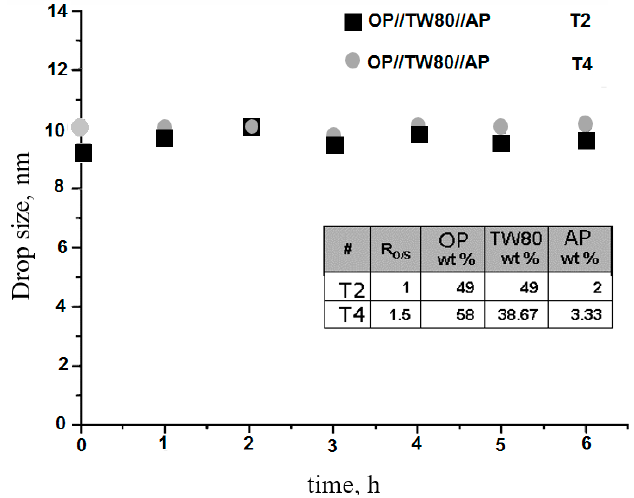
Figure 9. Drop size as a function of time for selected NEs for the OP//TW80//AP system at T = 25 °C.